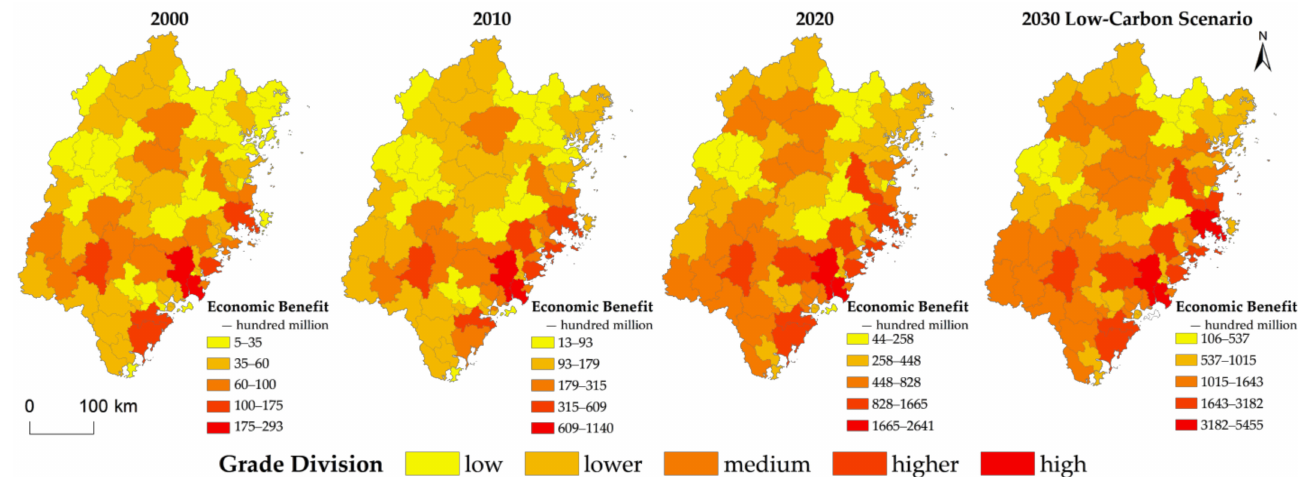
Figure 6. Spatial pattern evolution of land economic benefit in Fujian